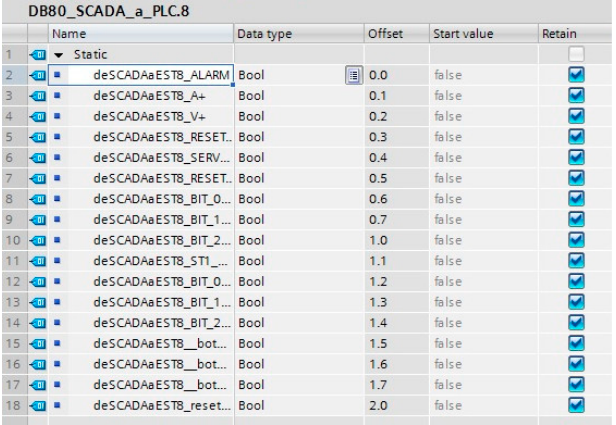
Figure 13. DB created to share data between SCADA and PLC of station 8.